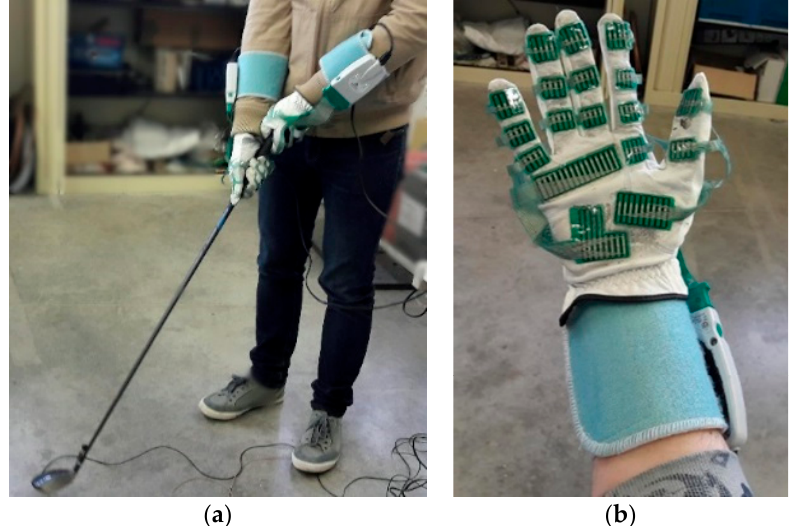
Figure 3. ( a ) Experimental modal analysis in grip-free boundary conditions. ( b ) Glove equipped with pressure sensors. Table 2. Measurements of contact pressure and surfaces in various grip strength conditions.